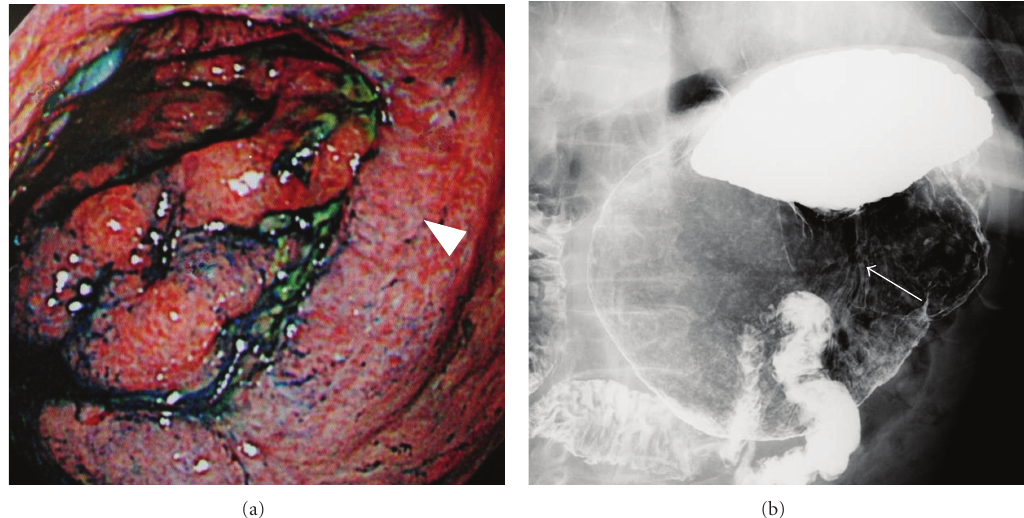
Figure 2: Marked deformity and shortening of the gastric angle (arrowhead) and lesser curvature (arrow), and insu ffi cient distention of the pyloric antrum on upper gastrointestinal endoscopy (a) and gastric fluoroscopy